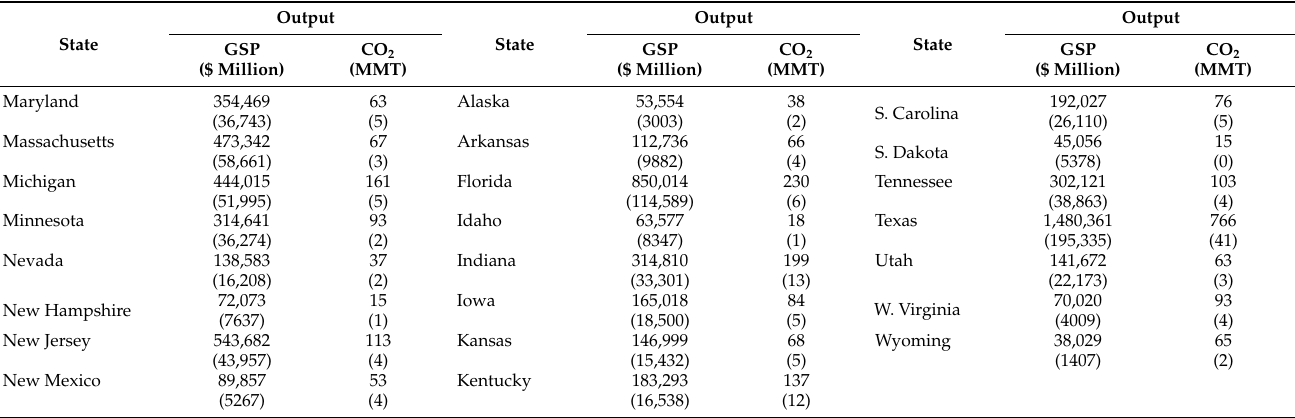
Figure 2. Average Unified Efficiency Scores of Blue and Red States from 2009–2018.